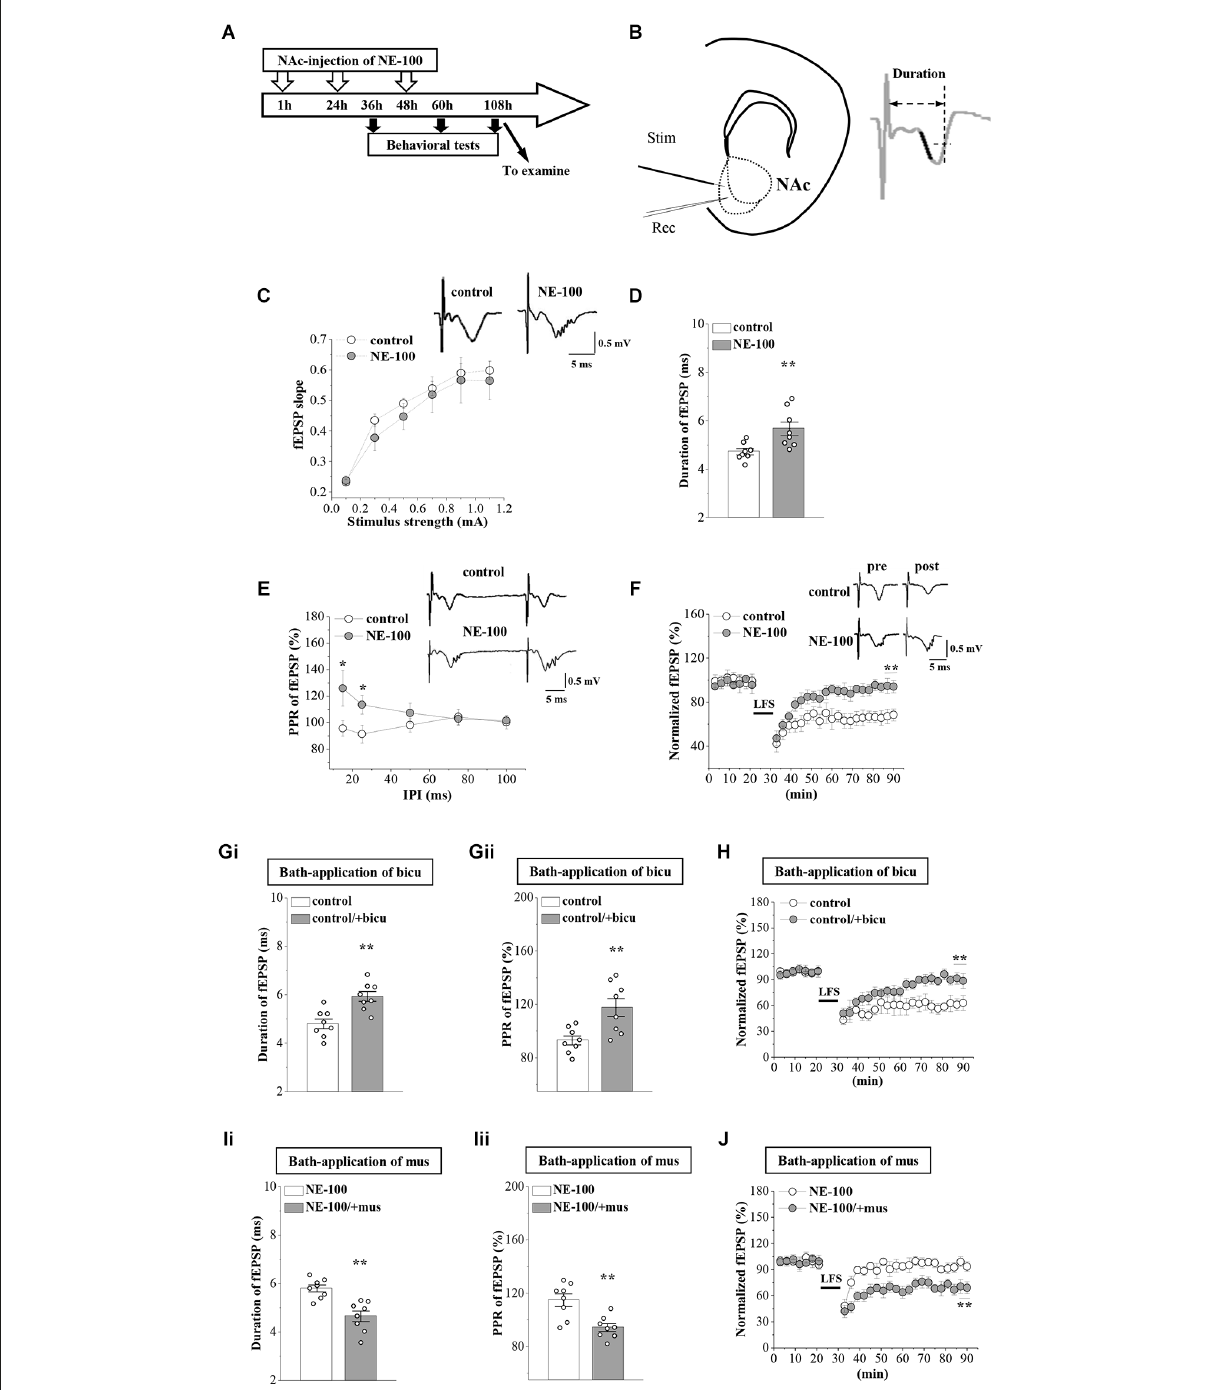
FIGURE2 Repeated injection of NE-100 leads to synaptic dysfunction. (A) The timecourse of the experimental procedure. (B) Schematic illustrating sites of stimulating electrode (Stim) and recording electrode (Rec) in the shell of NAc (left panel). The right panel shows a typical trace. The dark mark of the initial descending phase indicates the 10% to 90% data points of the slope, and the two-way arrow indicates the duration. (C) Input-output (I-O) curve in the NAc. Each point represents the group mean value of fEPSP slopes against stimulus intensity from 0.1 mA to 1.1 mA in control mice and NE-100 mice. Representative traces of fEPSP evoked at 0.5 mA stimulus intensity in control mice and NE-100 mice ( n = 8 slices/4 mice per group; repeated-measures ANOVA). (D) Bar graphs show the duration (ms) of fEPSP in control mice and NE-100 mice. ** p < 0.01 vs. control mice ( n = 8 slices/4 mice per group; Student’s- t test). (E) PPR (%) of fEPSP slopes was plotted against interpulse intervals (IPIs) ranging from